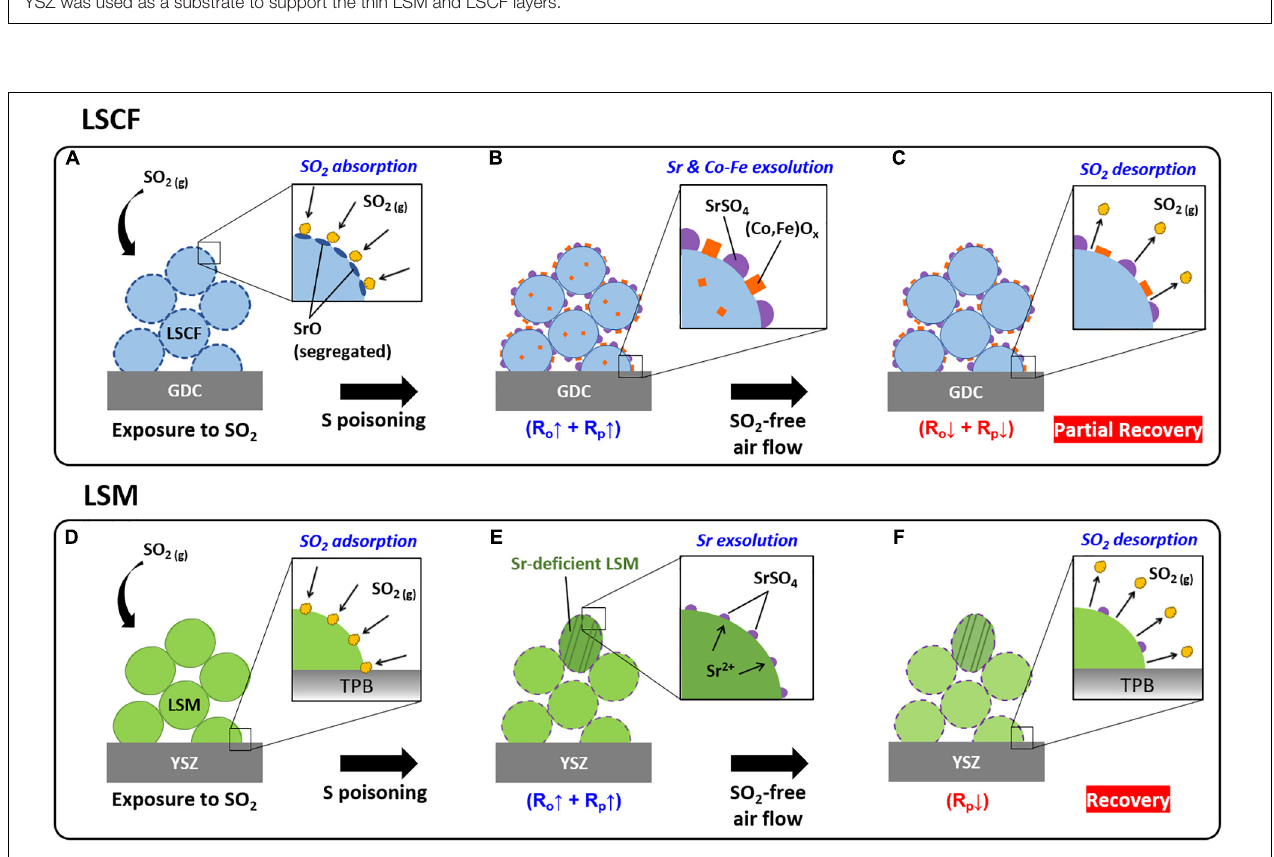
FIGURE 10 | Schematic diagram of the sulfur poisoning and recovery process of the LSCF and LSM electrodes under the presence and absence of SO 2 ( g ) : (A) SO 2 absorption at SrO present on the LSCF particle surface, (B) SrSO 4 formation and Co-Fe exsolution over LSCF, (C) SO 2 desorption and partial dissolution of SrSO 4 and (Co,Fe)O x onto LSCF under SO 2 -free air flow, (D) SO 2 absorption on the Sr-terminated LSM particle surface, (E) SrSO 4 island formation on the LSM surface leaving a Sr-deficient LSM, and (F) SO 2 desorption and partial dissolution of SrSO 4 onto LSM under SO 2 -free air flow.